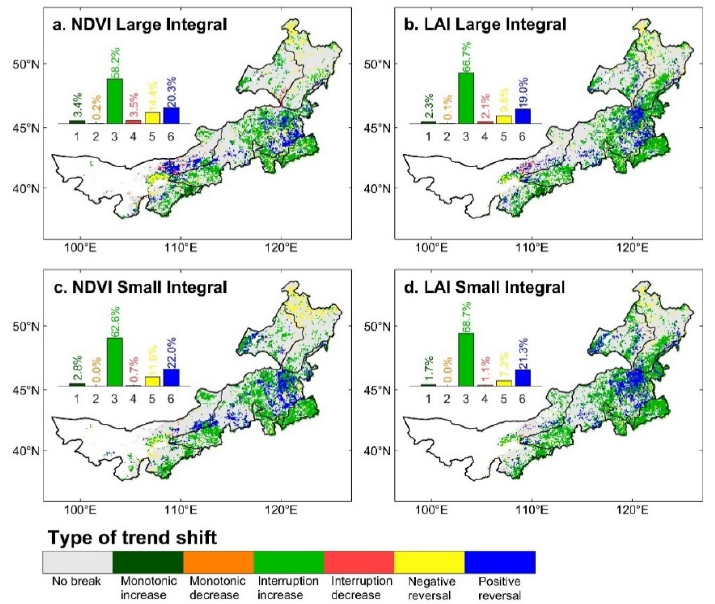
Figure 7. Spatial distributions of the trend shift type. ( a ) NDVI large integral; ( b ) LAI large integral; ( c ) NDVI small integral; ( d ) LAI small integral. Pixels with no breakpoint are reported in grey while white areas indicate regions with no data (i.e., non-vegetated areas or missing data). The histograms above each map summarize the distribution of six trend shift types.